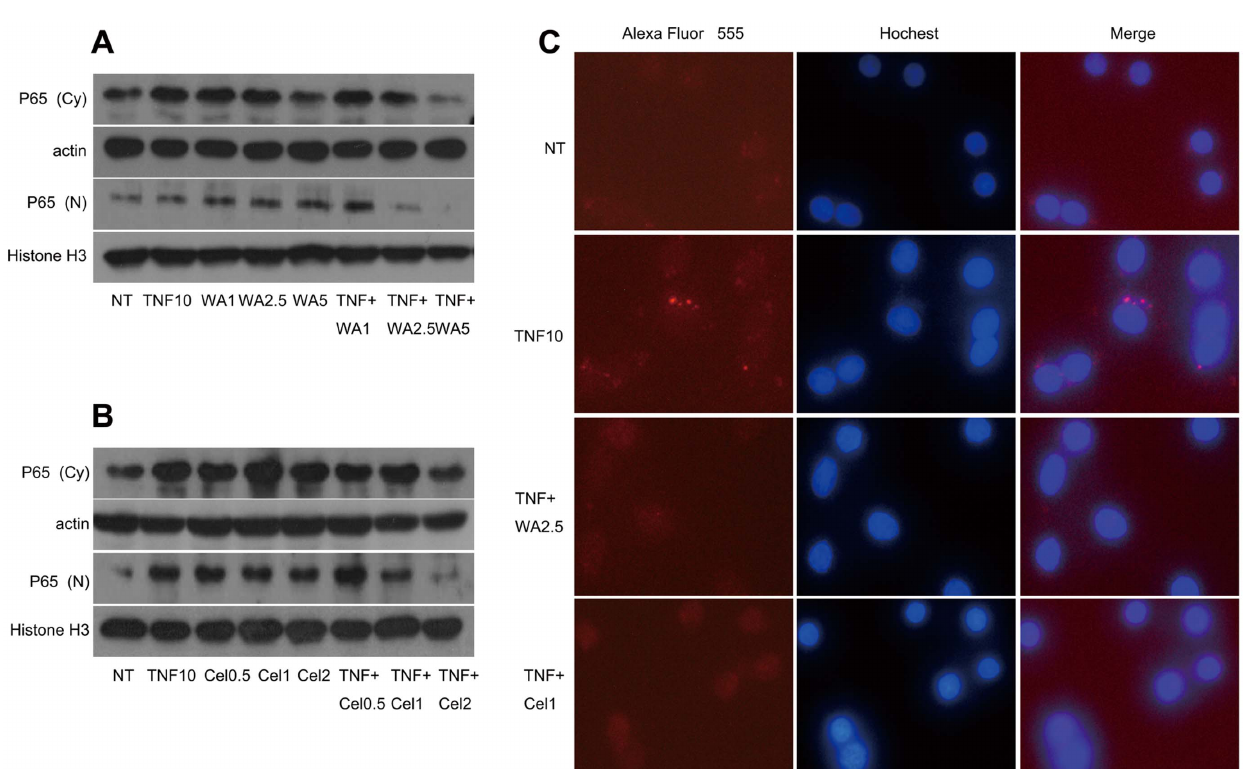
Figure 5. Effect of the combination of TNF- a and WA/Cel on nuclear translocation of NF- k Bp65 in cells. (A, B) The effects of WA (A) or Cel (B) on NF- k Bp65 activation. MDA-MB-231 cells were treated with different concentrations of WA or Cel with or without TNF- a (10 ng/ml) for 24 hours. The levels of NF- k Bp65 in cytoplasmic and nuclear fractions were analyzed by Western blotting. b -actin and Histone H3 were used as the cytoplamsic and nuclear marker respectively. (C) Inhibition of NF- k B binding activity by WA or Cel in TNF- a -stimulated MDA-MB-231cells. Cells were treated with TNF- a (10 ng/ml) with or without WA (2.5 m M) or Cel (1 m M) for 1.5 h. Nuclear translocation of NF- k Bp65 was observed by fluorescence microscope. Data are shown as mean ¡ SD of three